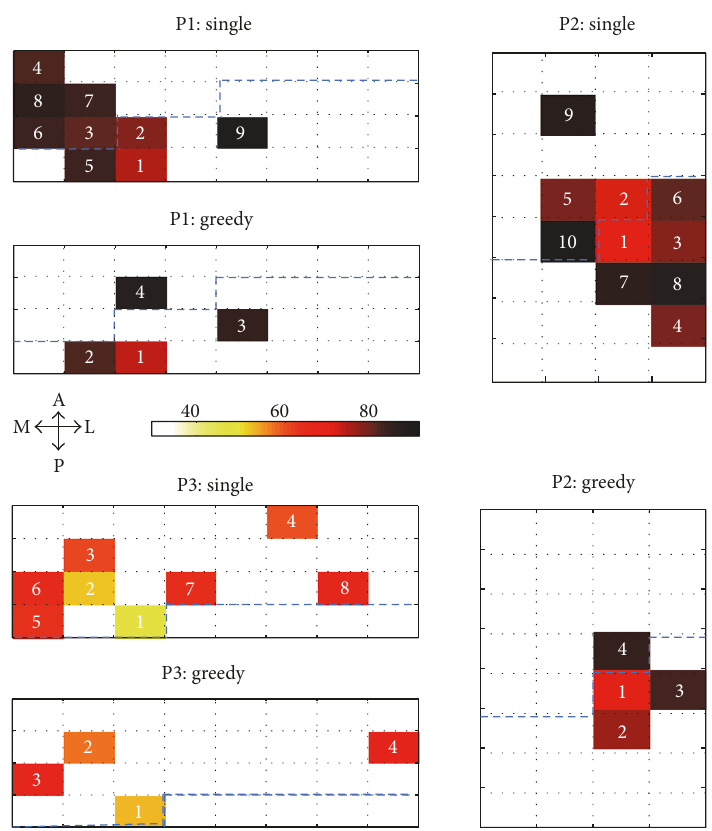
Figure 5: The spatial distributions of the selected channels using single channel selection and greedy selection of all three participants. The color bars give the scale of decoding performance. The numbers on the grid indicate the order of the selection. The performance yielded when the current channel was added into the selected decoding channel subset. All the ECoG grids are in 4 ∗ 8 con fi guration. Blue dash lines mark the central